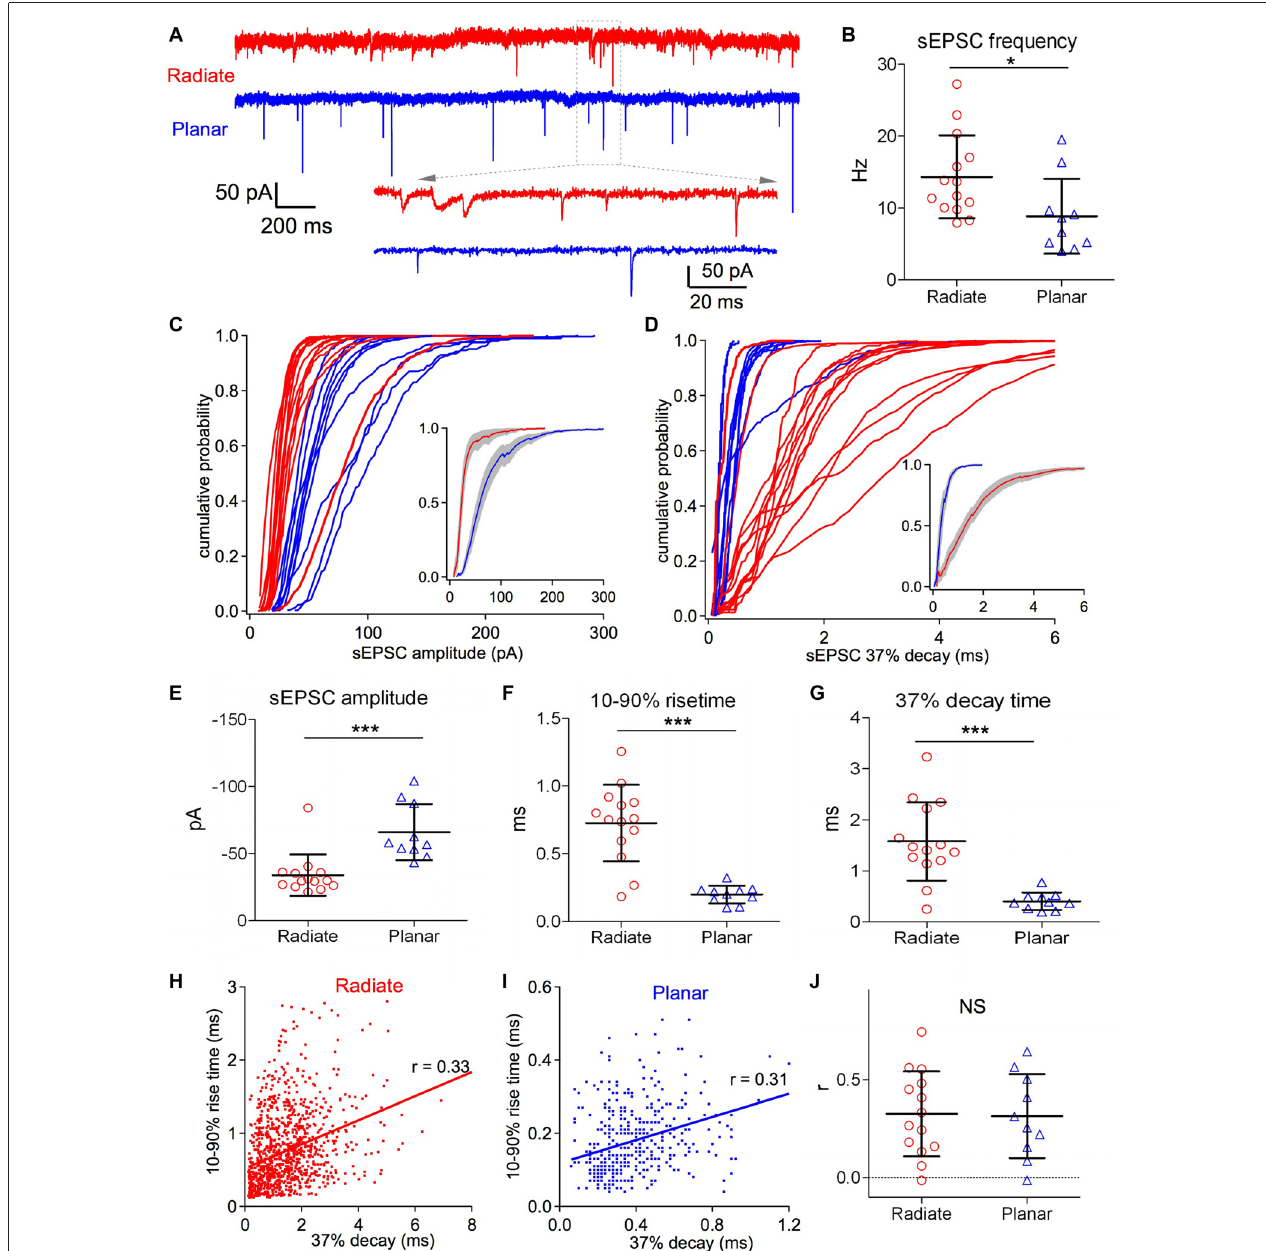
FIGURE 3 | Radiate cells have more diverse spontaneous excitatory postsynaptic current (sEPSCs) with smaller amplitude and slower kinetics than planar cells. (A) Example traces of sEPSC events from a radiate (red) and a planar cell (blue). Inset: magnified view of individual sEPSC events. Notice the variations in both size and kinetics of sEPSC events in the radiate neuron. Color-coding applies throughout the figure. (B) Average sEPSC event frequency in both cell types. ∗ p < 0.05. (C) Cumulative probability of the sEPSC event amplitudes for radiate and planar cells. Each curve represents an individual cell. Inset: average of the cumulative probability from all cells in each cell type; gray shaded areas represent the standard error of the mean. (D) Cumulative plots of the sEPSC 37% decay time. Inset: average of the cumulative plots from all cells in each cell type. (E–G) Summary plots of the average sEPSC amplitude (E) ; average sEPSC 10%–90% rise time (F) ; and average sEPSC 37% decay time (G) . ∗∗∗ p < 0.001. (H,I) Example plots of the 10%–90% rise time vs. peak to 37% decay time from individual sEPSC events of a radiate cell (H) and a planar cell (I) . Notice that the time scales in both the ordinate and the abscissa are different between (H,I) . Each dot represents an individual sEPSC event; line: linear regression; r : correlation coefficient. (J) Summary of all r values from both cell types. Each data point represents one cell. NS: not significant.